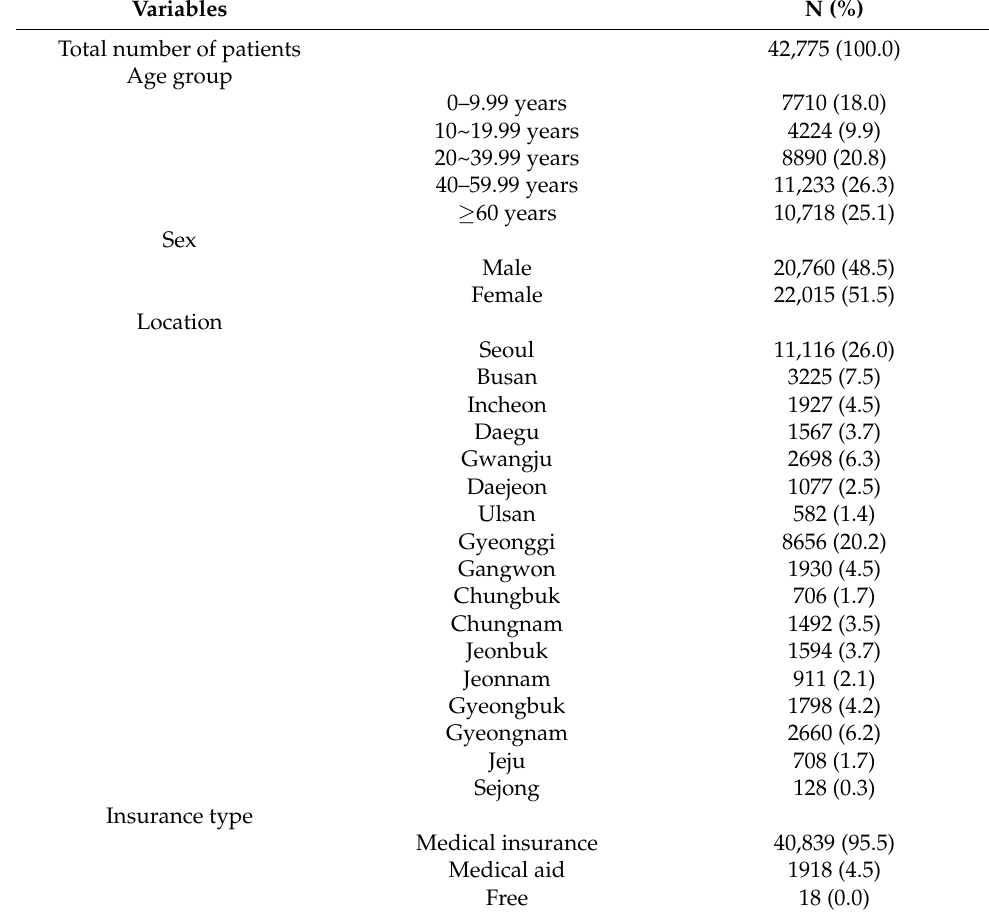
Table 1. Characteristics of patients.